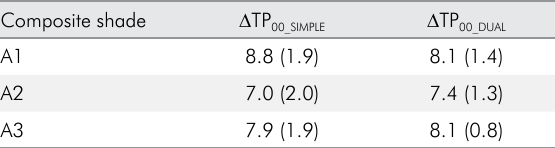
Table 2. Means (and standard deviations) for Δ TP00 values for simple or dual specimens of the composite Vittra APS Unique compared to control